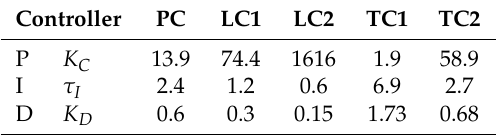
Table 4. Proportional–integral–derivative (PID) controllers gains for dual temperature control.